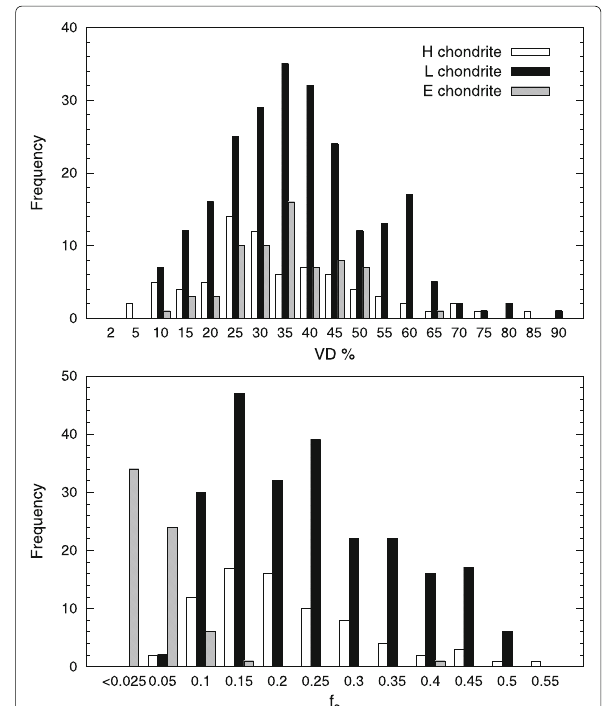
Fig. 12 Frequency of chondrules as functions of VD% and f